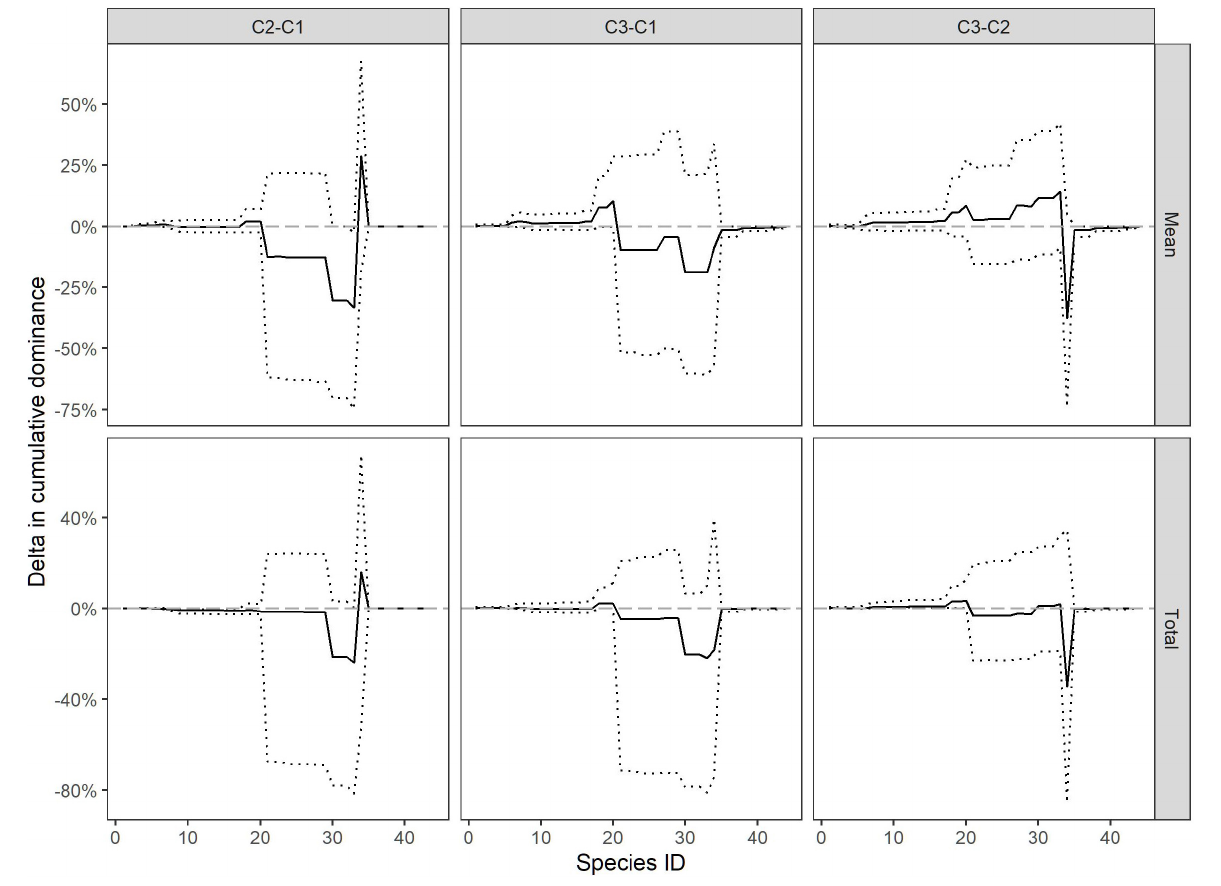
FIGURE 5 | Pairwise difference in dominance curves between cruises. Dashed lines are 95% confidence